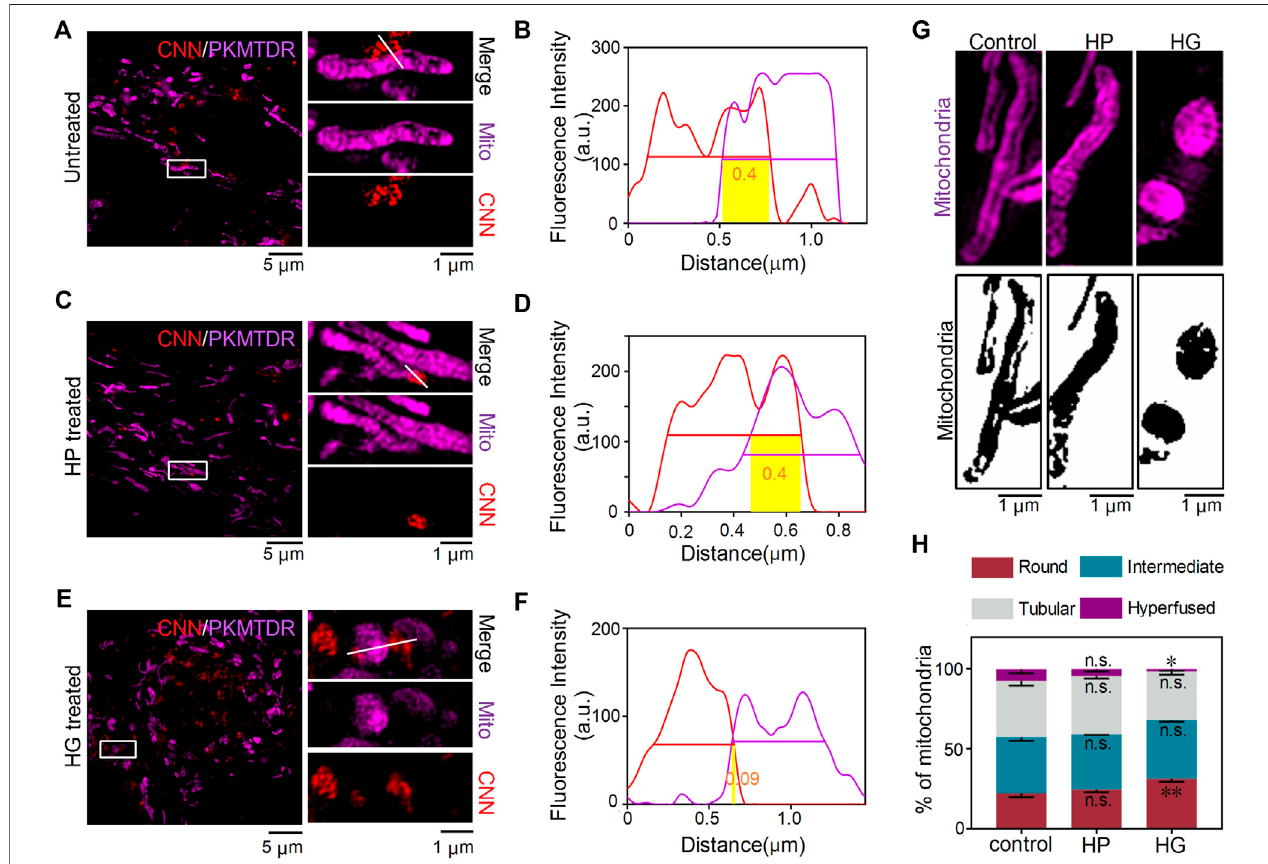
FIGURE 5 | CNN tracking of mitochondria – lysosomes contact sites in living H9C2 cells. (A,B) SIM images of MLC in untreated cells. The white line refers to a contact site between CNN (0.5 μ M, λ ex = 405 nm) and PKMTDR (0.5 μ M, λ ex = 640 nm). (C,D) MLC under mannitol treatment. The white line refers to a contact site between CNN and PKMTDR. (E,F) MLC under glucose treatment. The white line refers to a contact site between CNN and PKMTDR. (B,D,F) The yellow rectangle represents M-value . (G) Mitochondrial morphology of the control group, HP group, and HG group. (H) The quantitative analysis of mitochondrial morphology in H9C2 cellstreatedwithmannitol(HP) orglucose(HG).Roundmeans1.0 ≤ L/W < 1.5.Intermediatemeans1.5 ≤ L/W < 2.0.Tubularmeans2.0 ≤ L/W < 5.0.Hyperfused means L/W ≥ 5.0. Data are presented as mean ± SEM ( n = 3, n.s. represents no statistical signi fi cance; * p ＜ 0.05, ** p ＜ 0.01.). All compared with control group.